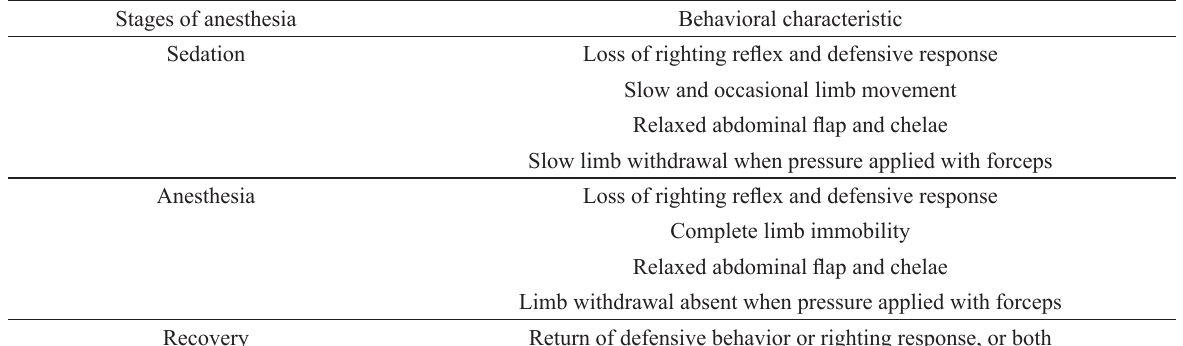
Evaluation of anesthetic stages for the crab Neohelice granulata